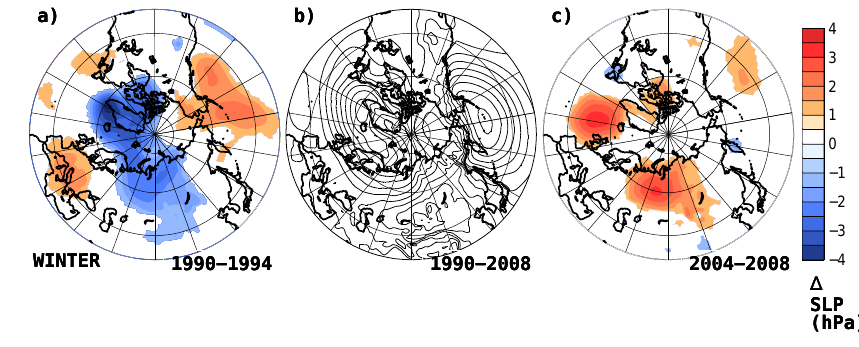
Fig. 5. Mean sea level pressure (SLP) during winter over the Arctic. The middle panel shows the mean SLP with contours at 3hPa interval (1990–2008). The left and right panels show the mean SLP for the period of interest (1990–1994, left; 2004–2008, right) minus the mean SLP over the entire time period. Blue and red areas display, respectively, lower and higher SLP than averaged over the whole